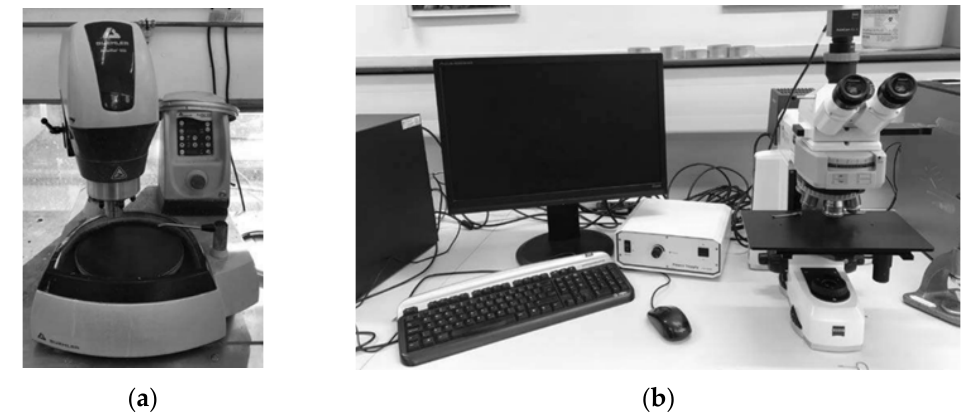
Figure 3. ( a ) Buehler Automet 250 Utilized for grinding and polishing processes throughout the experimental phases. ( b ) Zeiss Lens Microscope utilized in the current research with the magnification levels of 2.5× to 100×.